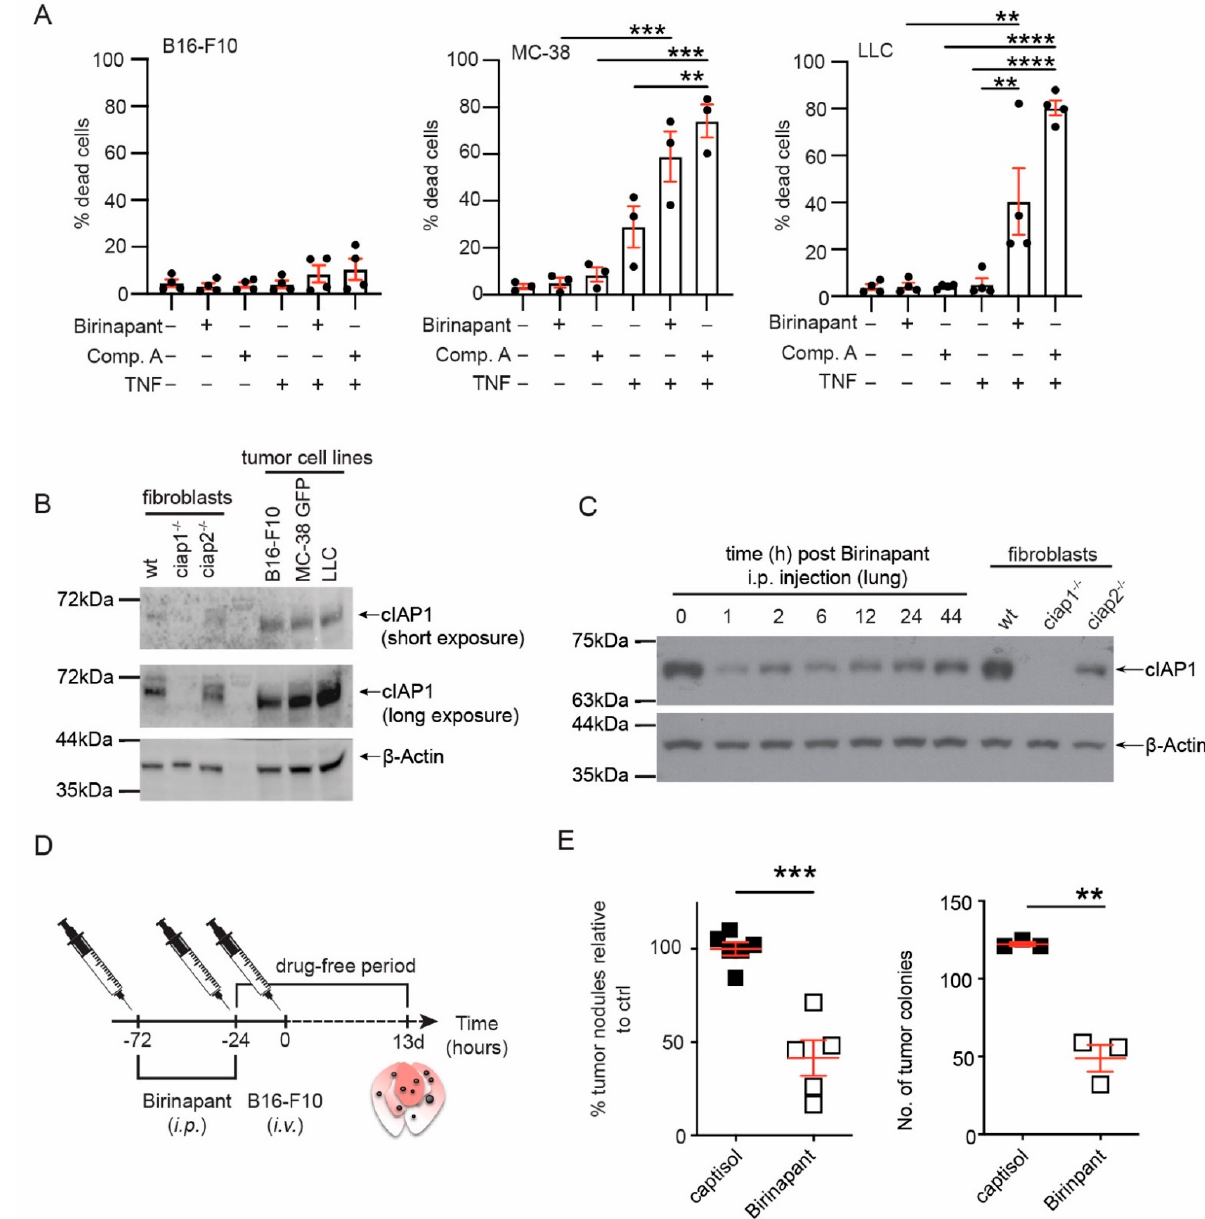
Figure 1. Smac mimetic, birinapant, reduces tumor nodules in the lung. ( A ) The cancer cell lines B16-F10, MC-38 GFP and LLC were treated with the Smac mimetics, birinapant (Bir, 500 nM) or Compound A (Comp. A, 500 nM), and/or mouse TNF (10 ng/mL). Comp. A is a bivalent Smac mimetic with affinity for XIAP, cIAP1 and cIAP2 [8]. Cell death was assessed by propidium iodide (B16-F10, LLC) or fixable viability dye eFLuor780 uptake using flow cytometry. ( B ) Levels of cIAP1 were assessed in the different cancer cell lines by Western blotting. A representative immunoblot is shown. ( C ) Wildtype (wt) mice were injected with birinapant (5 mg/kg, i.p.) and at the indicated time points, euthanized, lungs perfused, and total lung lysates were analyzed for cIAP1 by Western blotting. Shown is a representative immunoblot. The uncropped Western blots have been shown in Figure S6. ( D ) Experimental set up for Smac mimetic delivery and tumor cell injection. Wt mice were injected i.p. with birinapant (Bir, 5 mg/kg) or captisol (vehicle control) before the tumor challenge. Tumor cell nodules in the lung were counted 13 days post injection. ( E ) The number of tumor nodules counted in the lungs of mice treated with birinapant or vehicle control. To combine experiments, the number of tumor nodules for an individual mouse was normalized to the average number of tumor nodules counted in the lungs of mice treated with vehicle (captisol). Shown is a representative primary tumor nodule count. Each data point represents data obtained from an individual mouse. Data are presented as mean ± SEM with ** p < 0.01, *** p < 0.005 and **** p < 0.001 using one way ANOVA and multiple comparison test ( A ), two-tailed unpaired t -test ( E